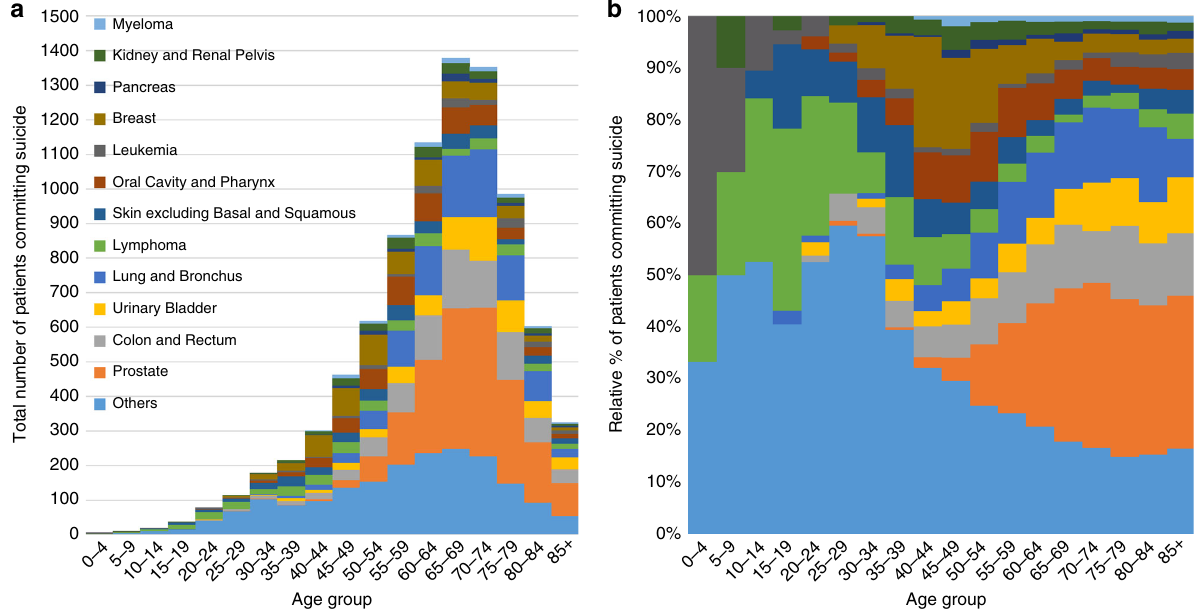
Fig. 2 Suicide among cancer patients as a function of age group. a The y-axis depicts the absolute number of suicides and the x-axis depicts the age group at time of diagnosis. The colors depict the disease sites. The majority of suicides are in patients diagnosed at an older age (i.e. 50 – 80-year-olds), and the plurality of suicides occurs in patients diagnosed with prostate, lung, and colorectal cancer. b The y-axis depicts the relative number of suicides compared to all cancer patients, and the x-axis depicts the age group at time of diagnosis. The colors depict the disease sites. For younger patients (i.e. <50), the plurality of suicides is seen in lymphoma patients. In contrast, among older adults (i.e. >50) the plurality of suicides occurs in patients with cancer of the prostate, lung, colorectum, and